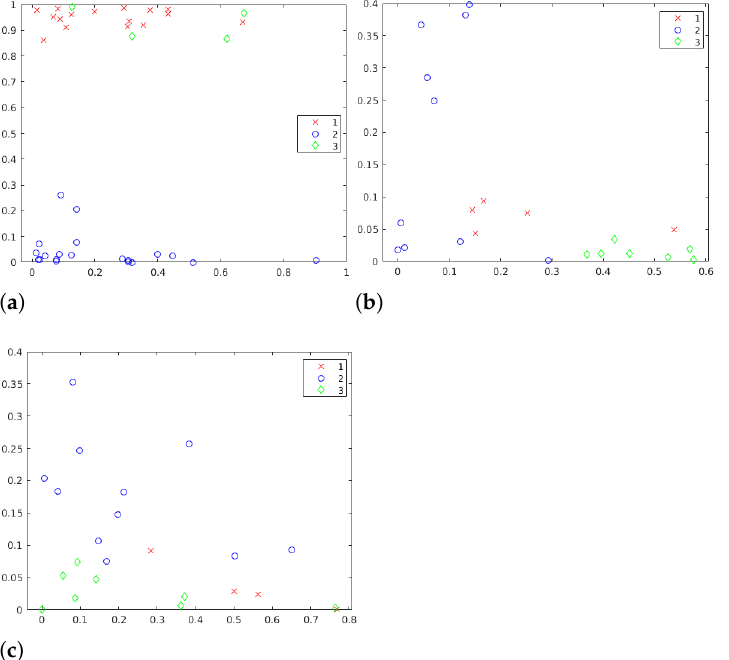
Figure 5. Scatter graphics in three different moments of year 1. ( a ) P1 year 1, k = 3, ( b ) P2 year 1, k = 3, ( c ) P3 year 1, k =